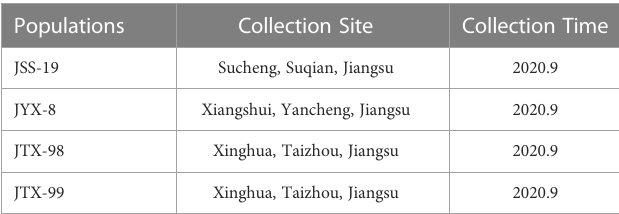
TABLE 1 D. ciliaris var. chrysoblephara seed collection